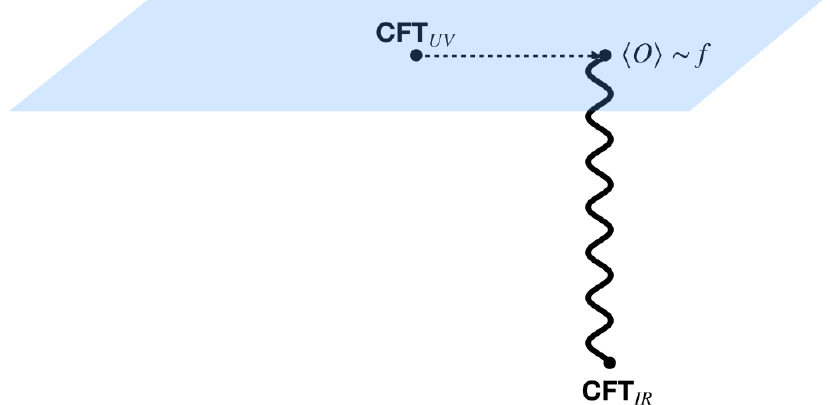
Figure 2 . Conformal symmetry of CFT UV is spontaneously broken by turning on a VEV h O i (cid:24) f . As a result the theory (cid:13)ows to a low energy theory consists of a CFT IR and a massless dilaton. three-point function and hence they are constrained by the conformal collider bounds